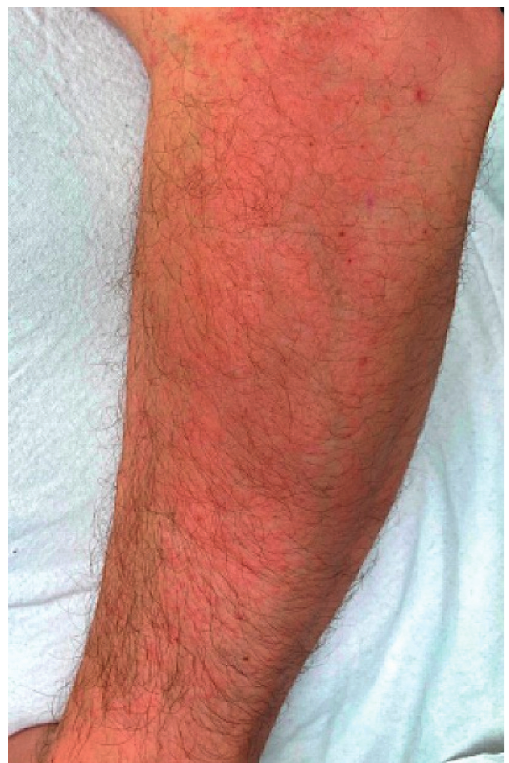
Figure 1: Pink papules coalescing into plaques on the left forearm. The rash extends into the posterior arm and is present bilaterally.